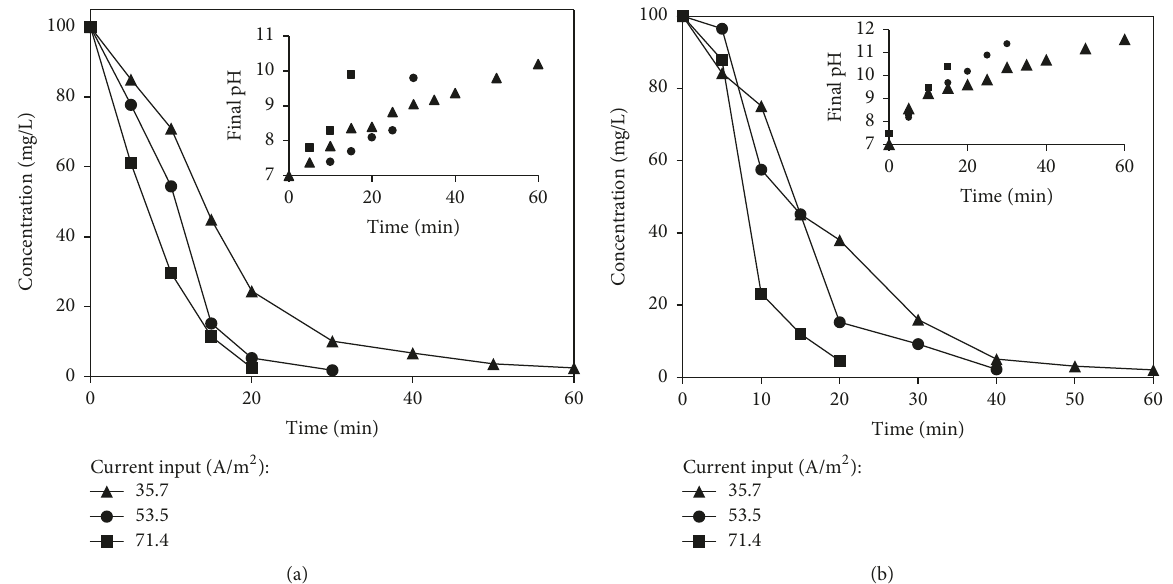
Figure 3: Effect of current density and final pH on the (a) Remazol yellow removal and (b) malachite green with 100 mg/L. 󳵳 : 35.7 A/m 2 , e : 53.5 A/m 2 , and ◼ : 71.4 A/m 2